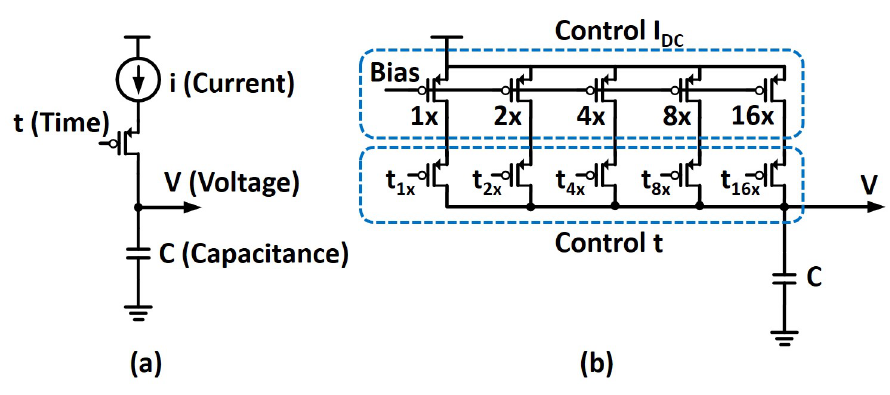
Figure 2. Hardware implementation of the approximate multiplier unit for distance computation. ( a ) Conceptual view ( b ) Actual